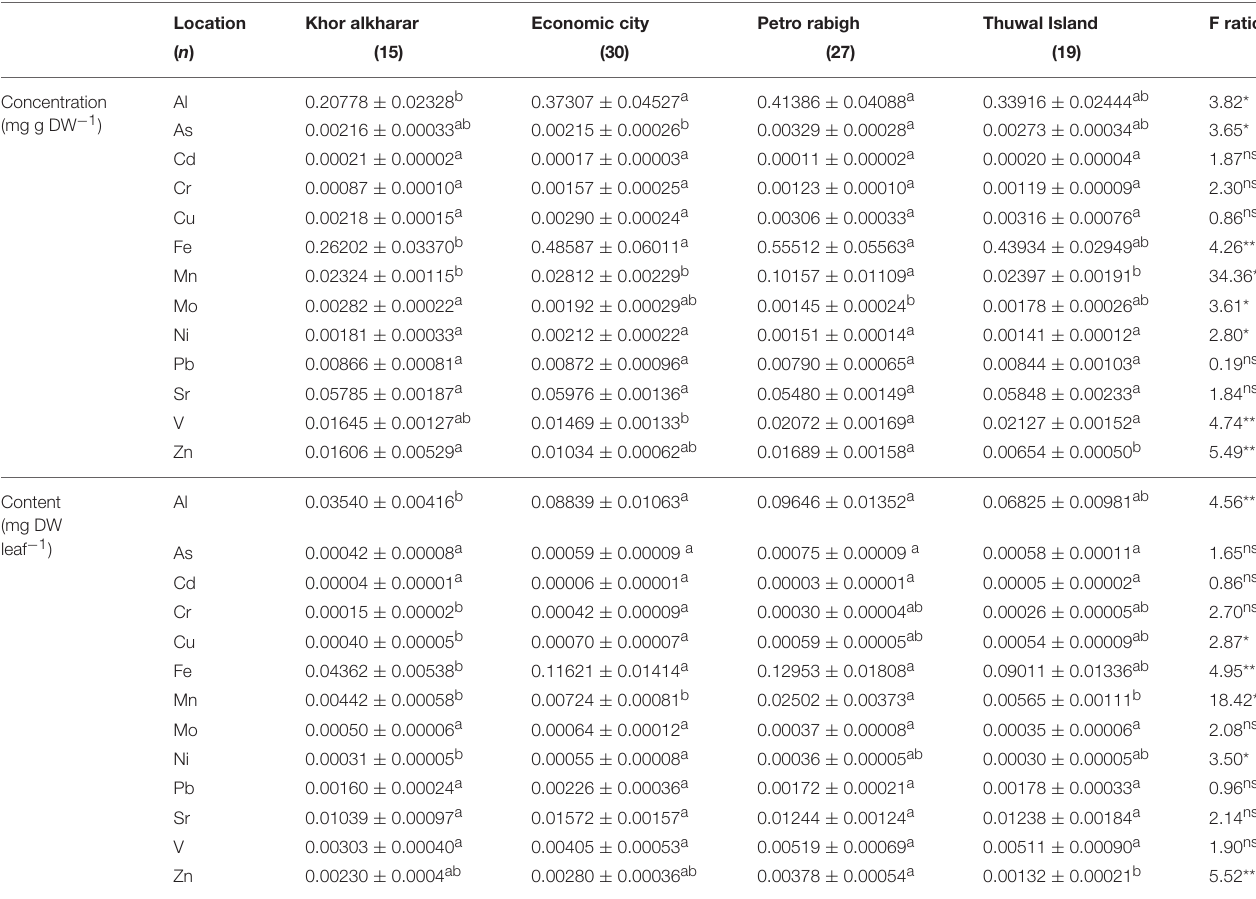
TABLE 1 | Mean ± SE for heavy metals concentration (mg g DW − 1 ) and content (mg DW leaf − 1 ) in Avicennia marina leaves from four different locations in the Central Red Sea, and the results from ANOVA and Tukey HSD post-hoc tests for differences among